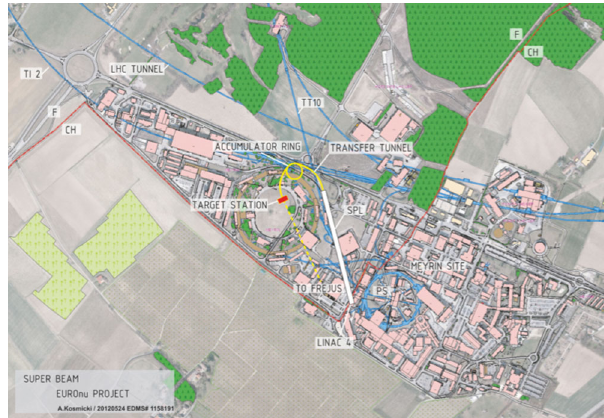
FIG. 2. Layout of the Super Beam facility at CERN. The yellow line shows the transfer lines from SPL and the accumulator ring, while the red box shows the location of the target station, in the ISR area. (Image provided courtesy of Elena Wildner and the CERN Civil Engineering